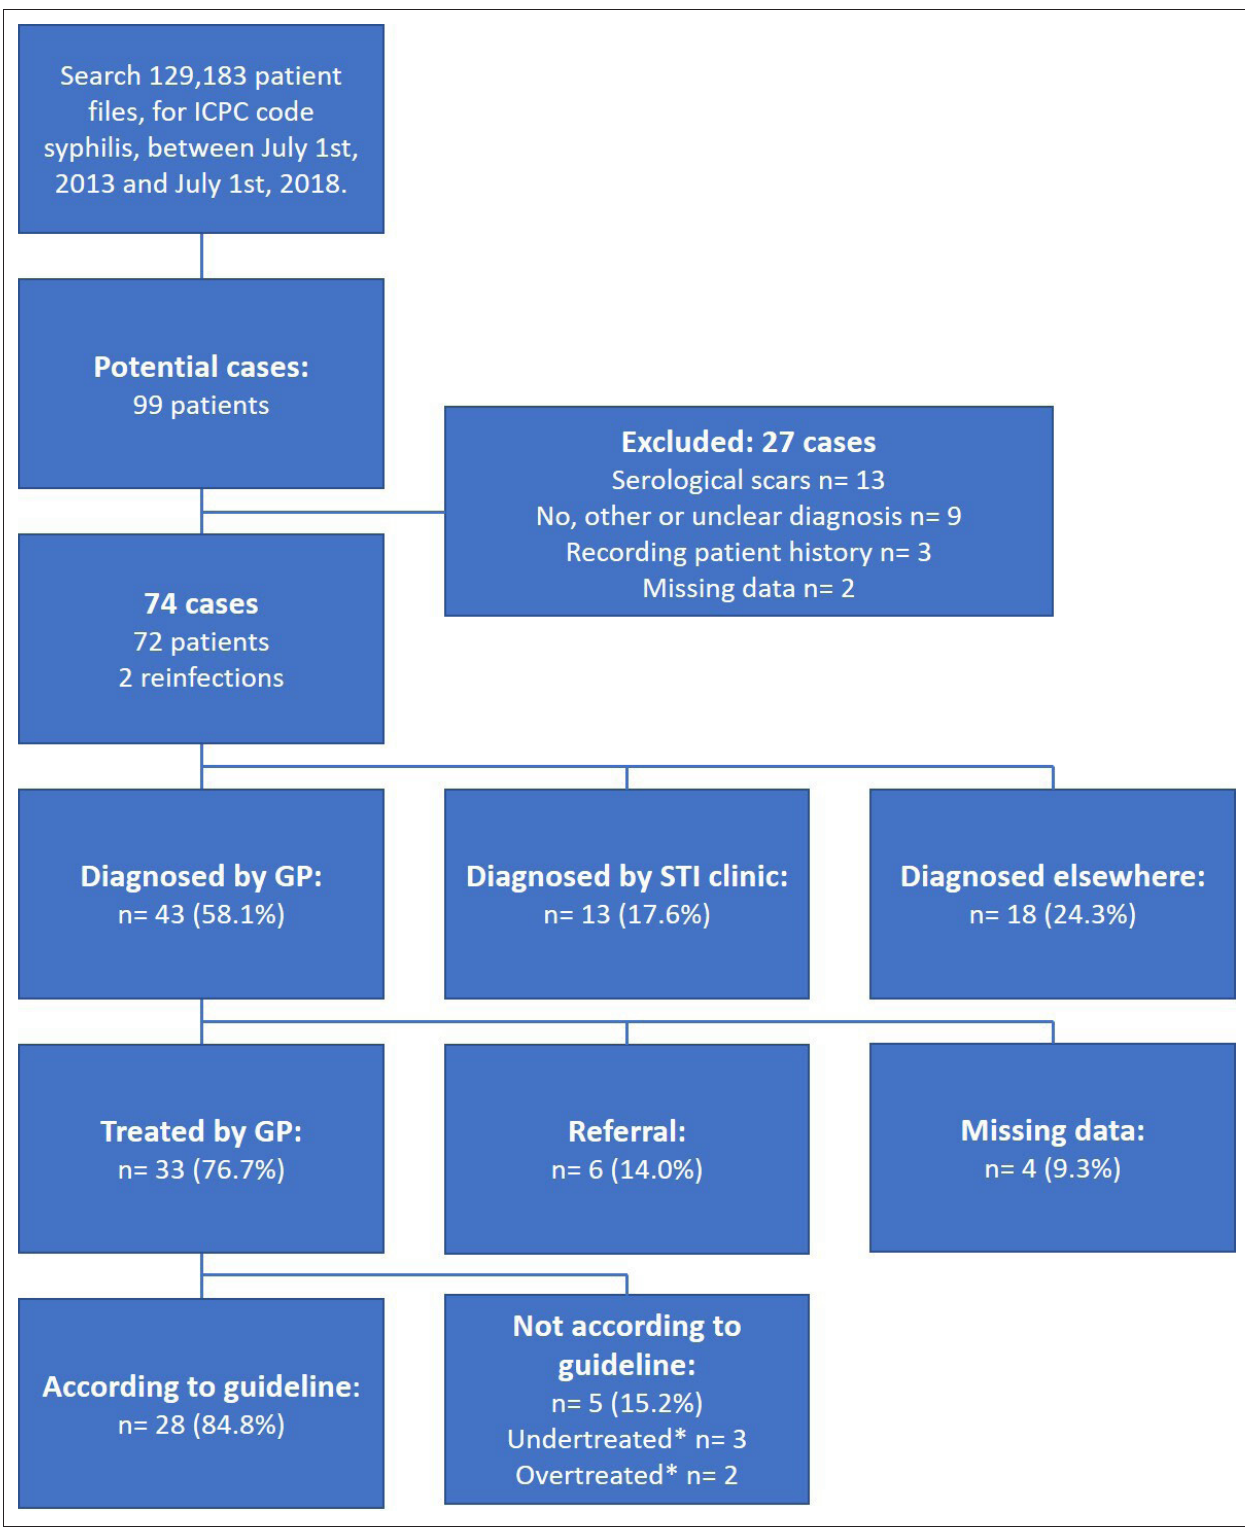
Figure 4 Potential syphilis cases and treatment of cases in general practice, separated by site of diagnosis. *Based on the stage of disease the first choice treatment of syphilis consists of one or three penicillin injections. Undertreated is when one penicillin injection was given when three were recommended by the guideline, and vice versa for overtreated. ICPC = International Classification of Primary Care. STI = sexually transmitted